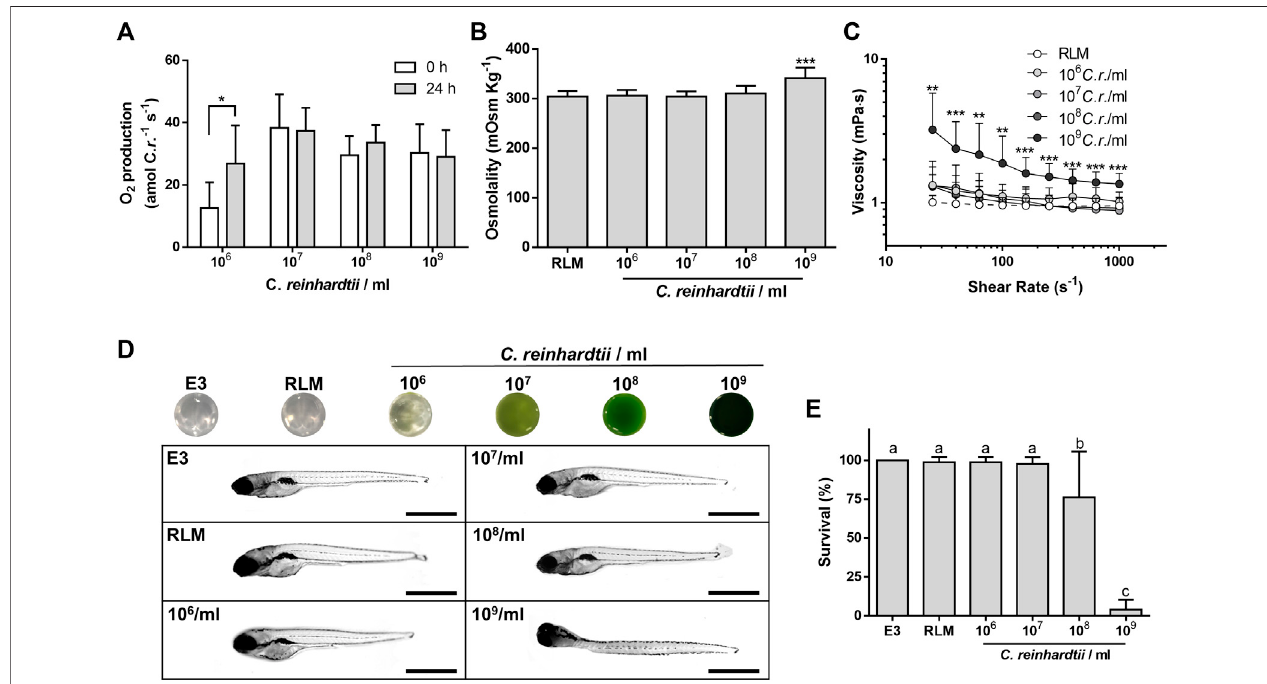
FIGURE3| Characterizationofthephotosyntheticsolution.Differentdensitiesof C.reinhardtii wereaddedtoastandardsolutionfororganpreservation(RLM).The oxygen production rate of microalgae was maintained after 24 h, except for 10 6 C. reinhardtii /ml, which increased (A) . Up to 10 8 C. reinhardtii /ml, no signi fi cant differences were observed in the osmolality (B) and rheological properties of the solution (C) . Zebra fi sh larvae were exposed for 24 h to photosynthetic solution containing different densities of microalgae, in the dark. Up to 10 8 C. reinhardtii /ml larvae presented normal phenotypes compared to control [E3; (D) ]. Mild and severemortalitywereobservedat10 8 and 10 9 C.reinhardtii /ml,respectively (E) .Scalebarsrepresent1 mminD. Dataareexpressed asmean ± SD; N (cid:2) 3,4;* p < 0.05, *** p ≤ 0.001 (one-way ANOVA followed by Tukey ’ s test in A; one-way ANOVA followed by Dunnett ’ s test in B; two-way ANOVA followed by Sidak´s test in C); different letters in E indicate signi fi cant differences with p < 0.05 (one-way ANOVA followed by Tukey´s test).